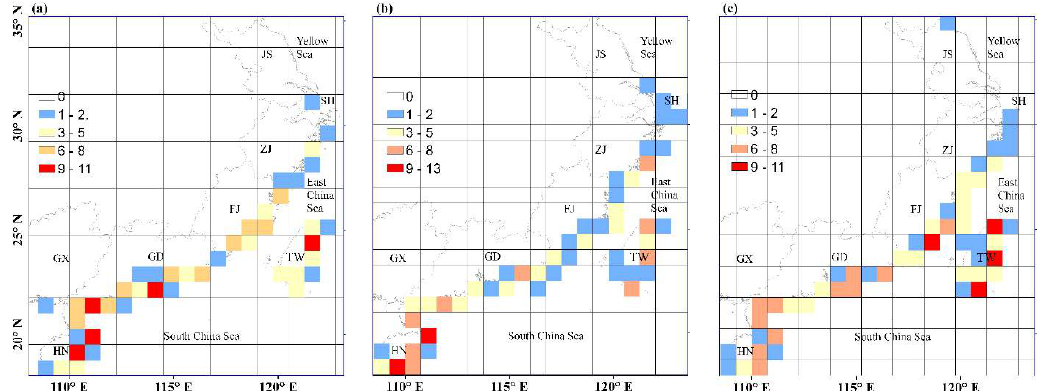
Figure 9. The spatial distribution grid of TC landfall positions in ( a ) 1960–1978, ( b ) 1979–1994, and ( c ) 1995–2016.